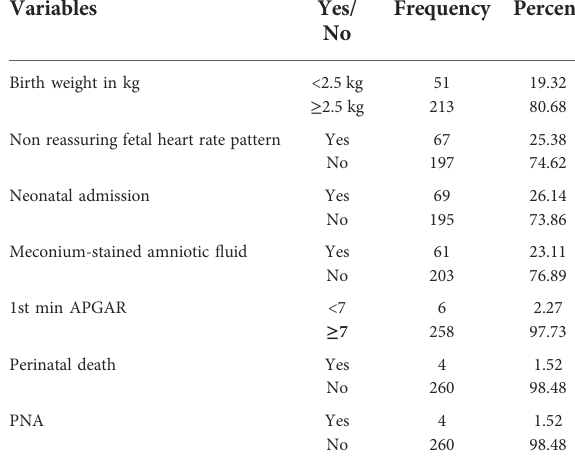
TABLE 4 Type of labor and mode of delivery of participants, 2021 [ N =264].